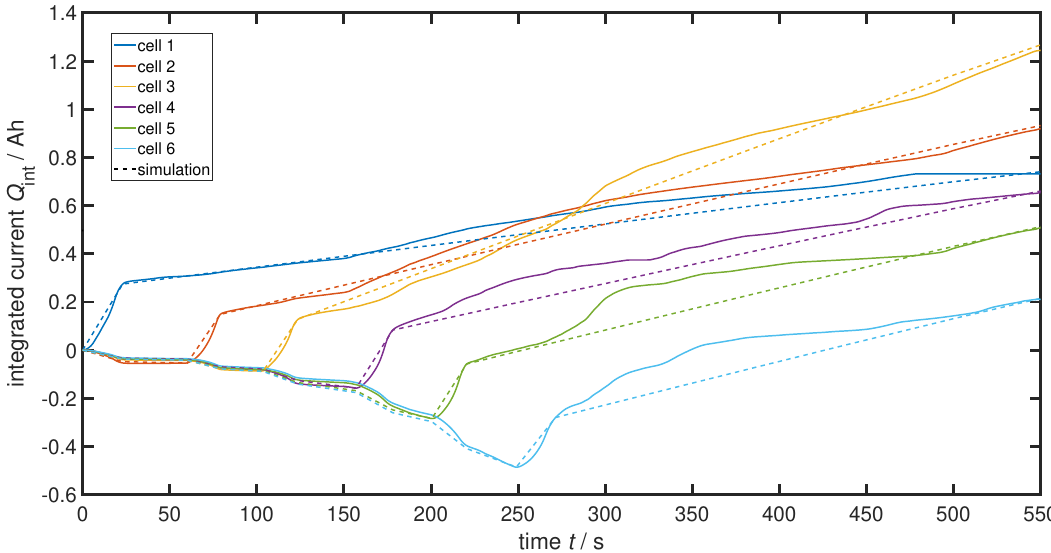
Figure 6. Current integrals of the first six cells from Figure 4 as solid lines. The dashed lines represent the simulation results with the estimated parameters set into the equivalent circuit model (ECM) from Figure